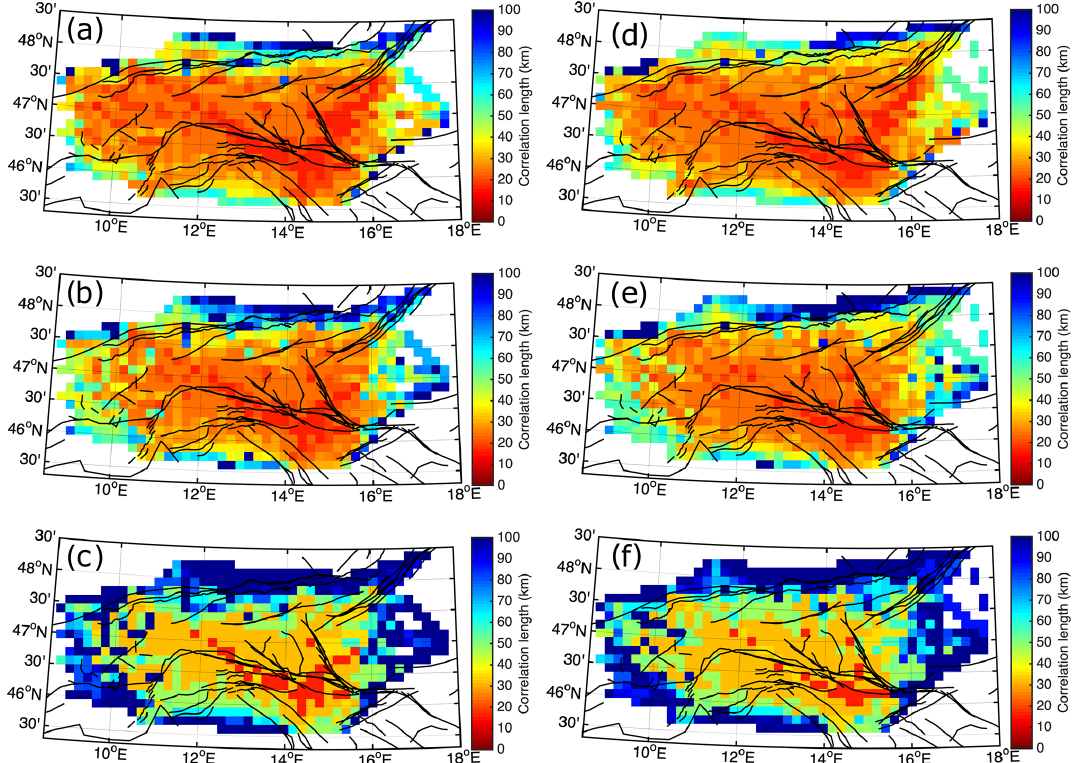
Figure 7. Resolution of the group velocity inversion shown via correlation length maps for a 20s center period. Colors show the correlation length, e.g., the distance for which the value of the resolution matrix decreases to half. Rayleigh waves: (a) correlation length in the best direction. (b) Mean correlation length for each cell. (c) Correlation length in the worst direction. Love waves: (d) correlation length in the best direction. (e) Mean correlation length for each cell. (f) Correlation length in the worst